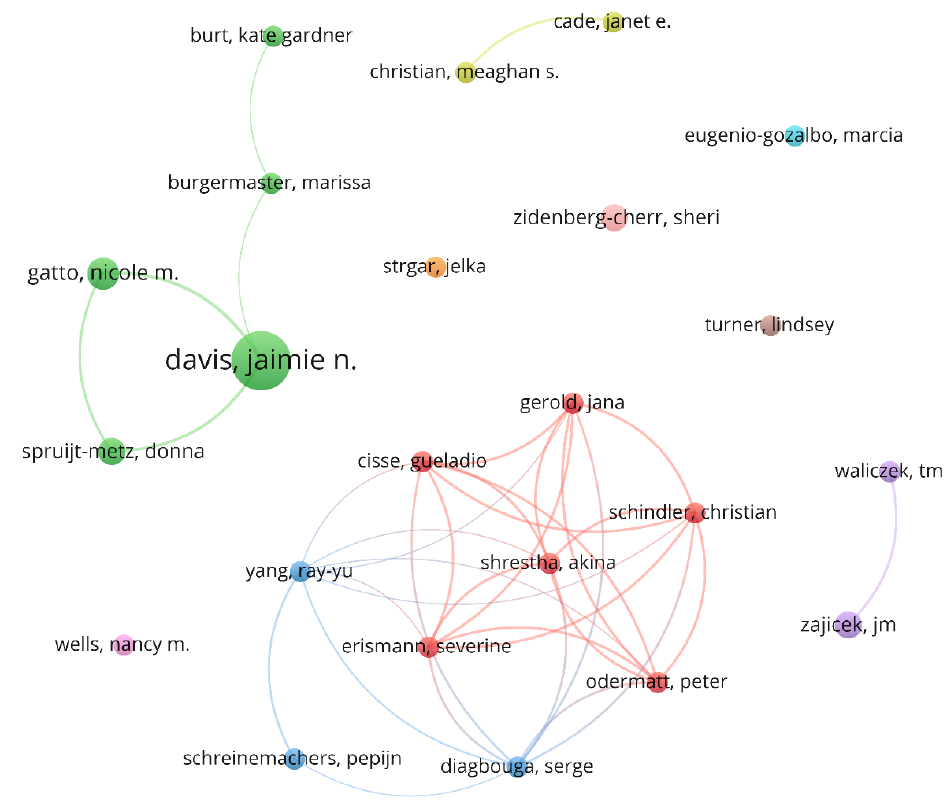
Figure 3. Prolific co-authorship graph. The colors indicate the cluster.